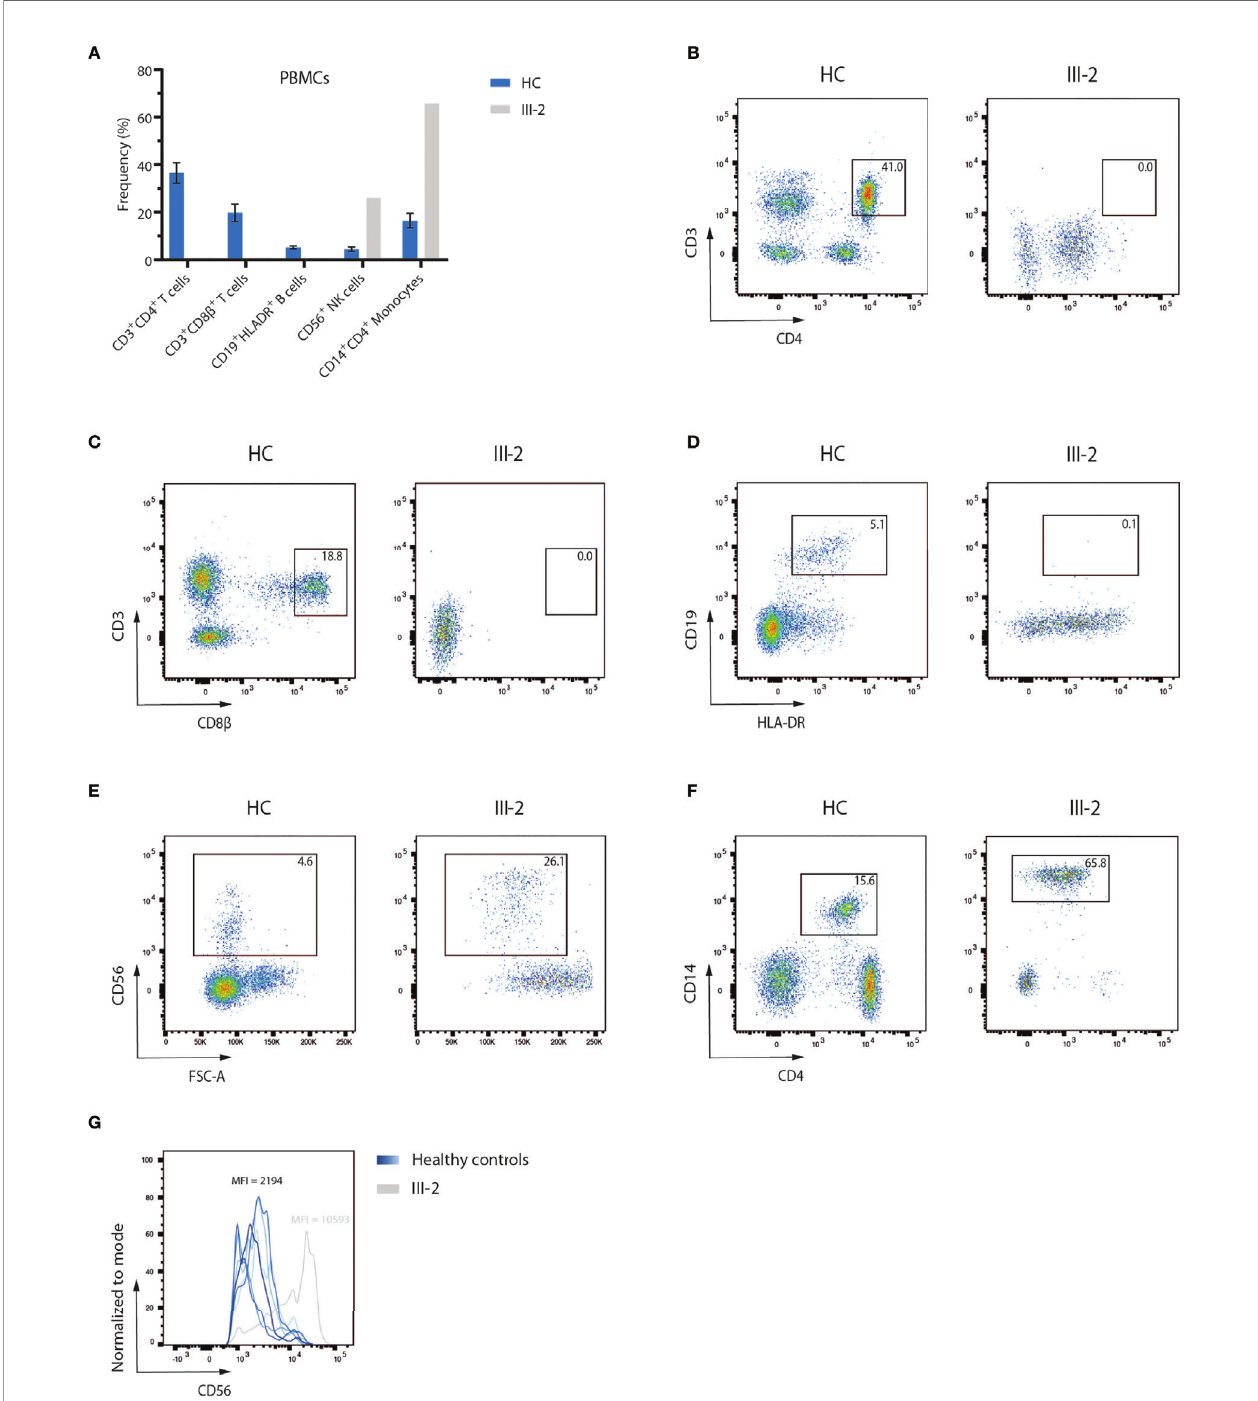
FIGURE 1 | Flow cytometry analysis of PBMCs of a SCID patient shows a lack of T and B lymphocytes (A) Flow cytometry analysis of PBMCs of six healthy children and the index patient (III-2). Bars indicate the mean of the corresponding populations with error bars as the standard deviation. HC, Healthy Control; PBMC, Peripheral Blood Mononuclear Cells. (B – F) Pseudocolor plots of CD3 + CD4 + and CD3 + CD8 b + T cells, CD19 + HLADR + B cells, CD56 + NK cells and CD14 + CD4 + monocytes in both a representative healthy control and the index patient. Numbers indicate the percentage of the gated populations. HC, Healthy Control. (G) Flow cytometry analysis of the CD56 expression level on peripheral NK cells, corresponding to the pseudocolor plots in (E) . Numbers indicate the geometric mean fl uorescence intensity (MFI) of CD56